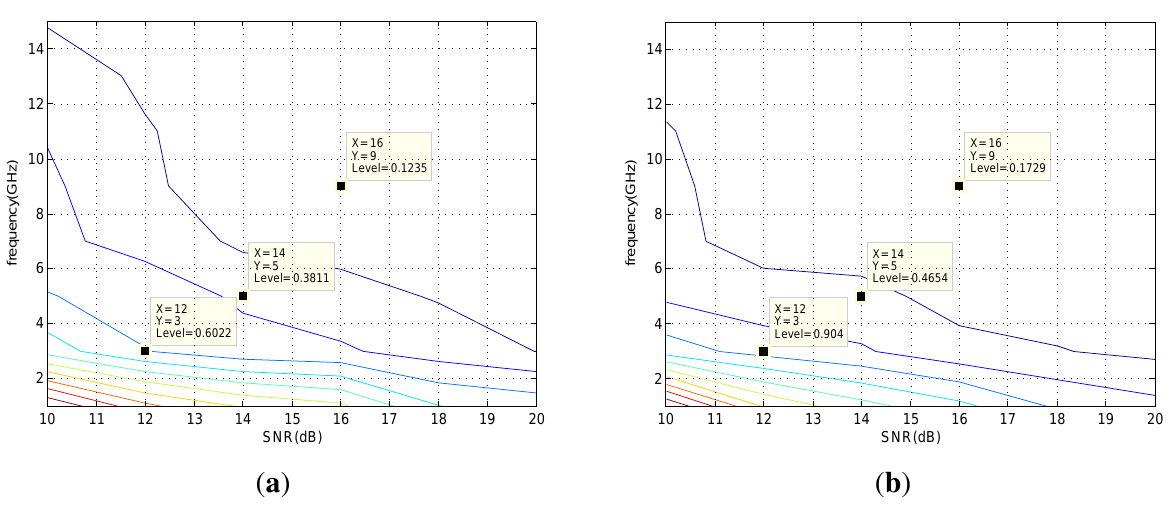
Figure 12. Comparison of RMSE of 2D array with respect to different frequency and SNR. ( a ) β = 80 ◦ ; ( b ) β = 60 ◦ .